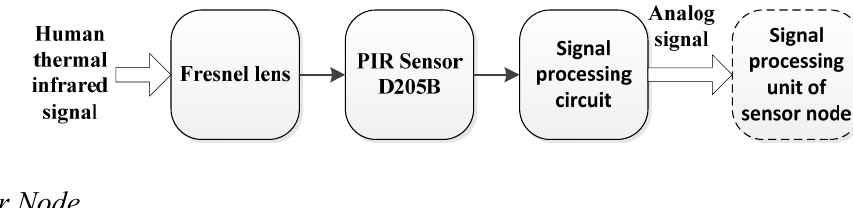
Figure 2. Human thermal infrared signal processing in sensor module.